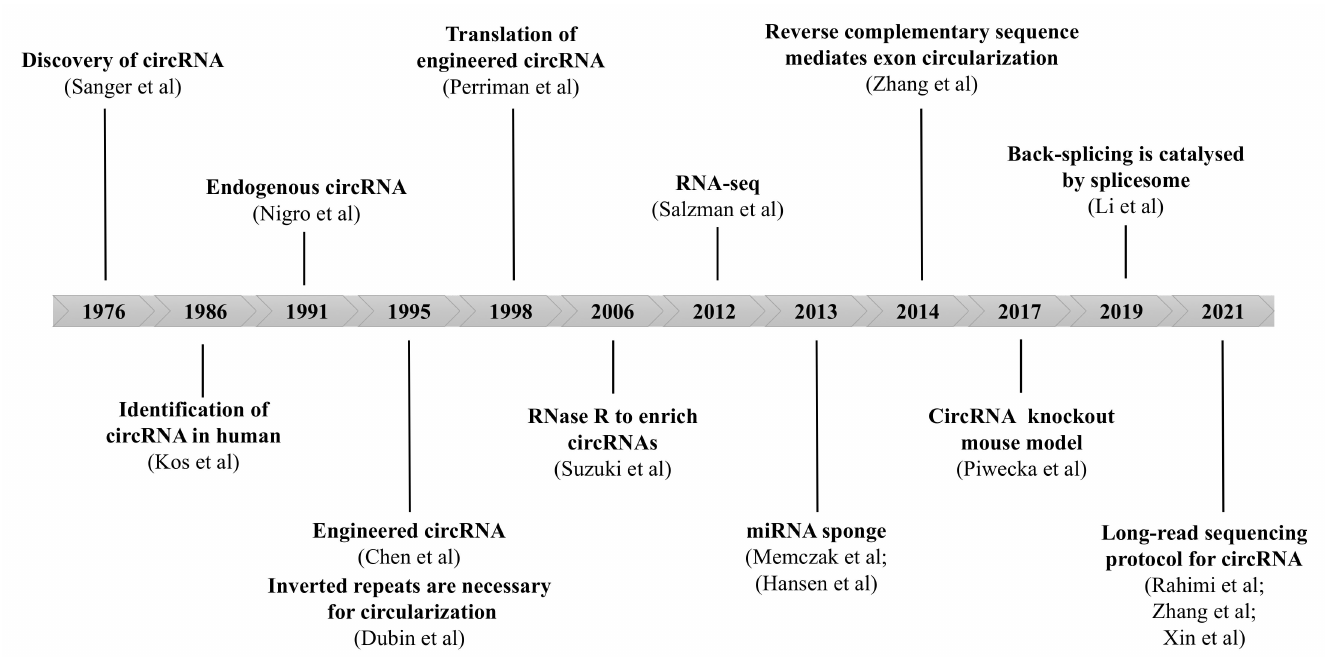
Figure 2. Overview of research history of circRNA. The discovery of circRNA starts with identification of viroids, which was published in 1976. Subsequent investigations and novel technologies revealed the biogenesis and properties of circRNA. (see Refs.